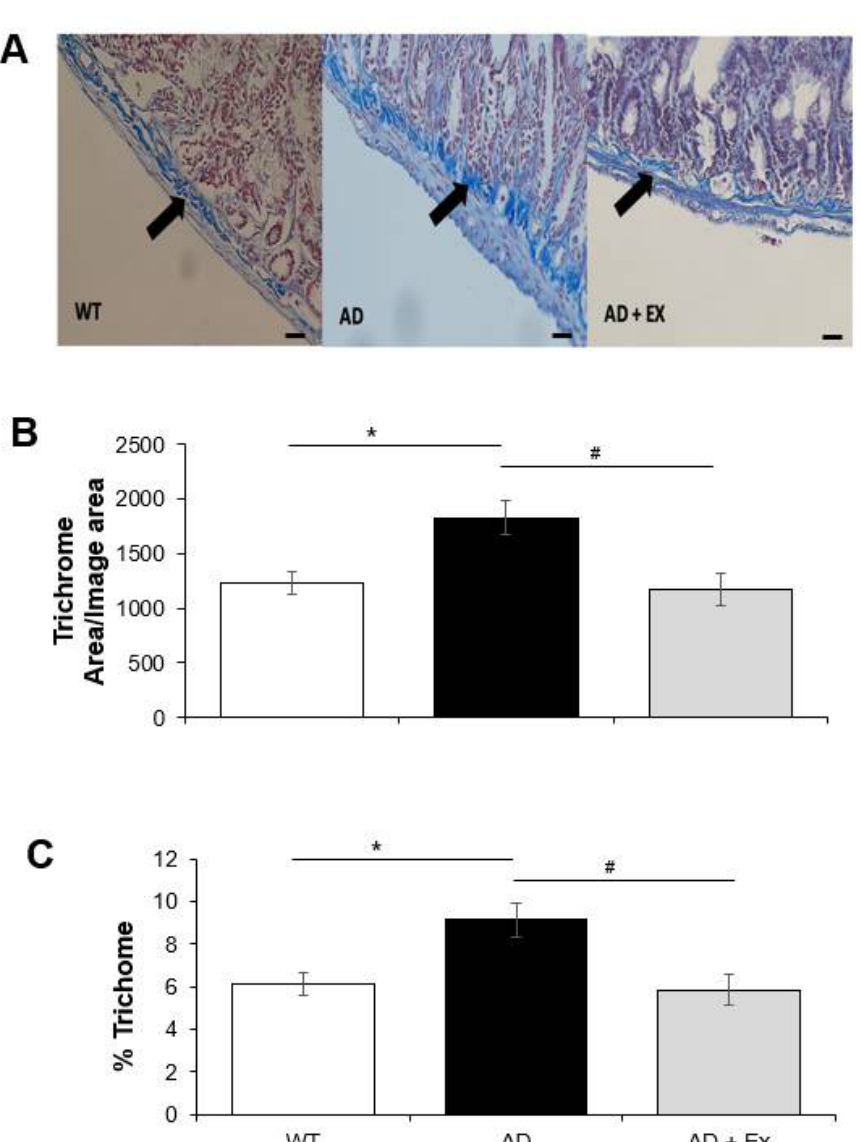
Figure 4. The effects of effects of exercise training on collagen content in 3xTg-AD mouse jejunum. Trichrome staining was used to determine collagen content. Representative 20 × images are shown ( A ), trichrome area (representing the ratio of trichrome stained area over the entire area evaluated, and expressed as arbitrary units) ( B ) and percentage of trichome ( C ). Scale bars are 50 µ m. Values are reported as mean ± SEM for 23–31 measurements per group. * indicates significance compared to WT control mice, p < 0.05; # indicates significance compared to 3xTg-AD mice, p < 0.05. AD, Alzheimer’s disease; WT, wild type; Ex, exercise.